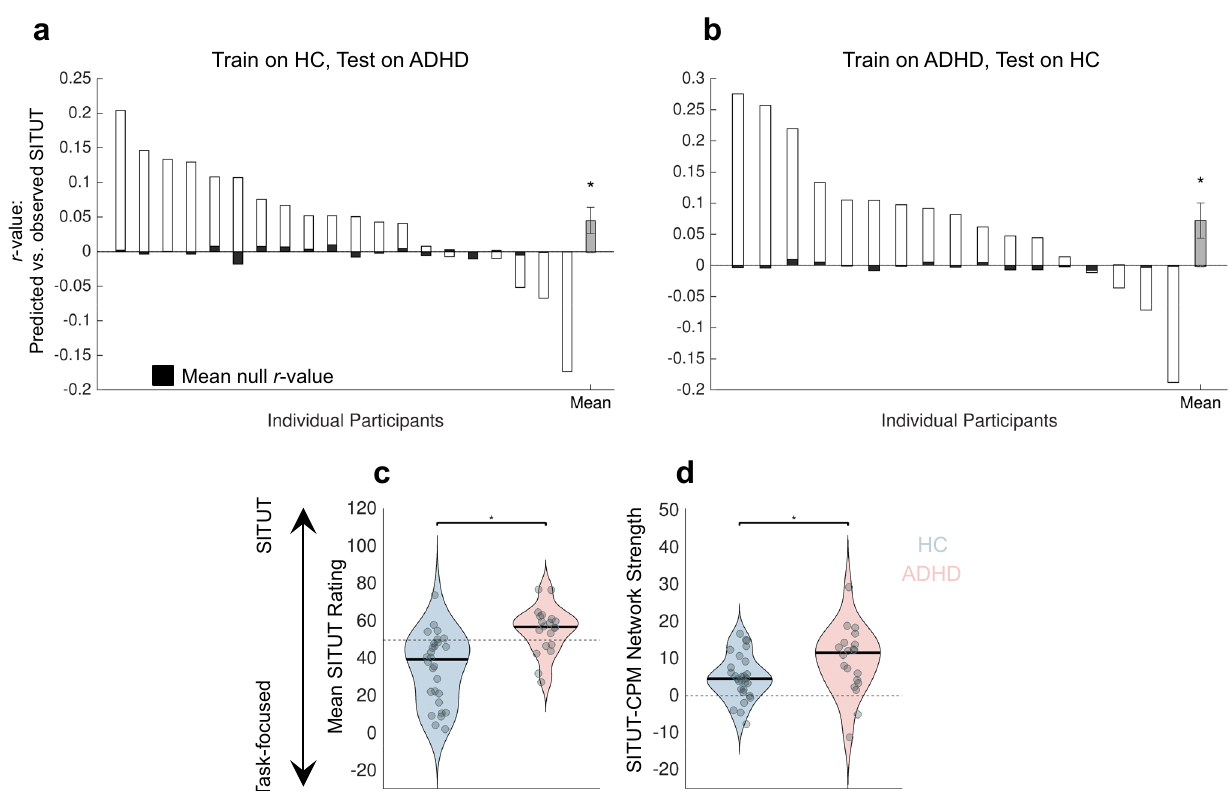
Fig. 3 The SITUT-CPM is sensitive to intra-individual mind wandering in adults with ADHD. a Predicted versus observed SITUT correlations, and mean null correlations, within each held-out participant with ADHD, based on the SITUT-CPM generated in healthy control (HC) participants. At the group level ( n = 20 individuals with ADHD), predicted versus observed correlations were signi fi cantly greater than mean null correlations (* P = 0.028, two-sided, Wilcoxon signed-rank test). The gray bar indicates the mean across individuals (i.e., mean across white bars). b Same as a but for held-out HC participants ( n = 17) based on a CPM generated to predict SITUT within ADHD participants (* P = 0.015, two-sided, Wilcoxon signed-rank test). c Mean SITUT ratings were signi fi cantly greater in the ADHD compared to HC group (* P = 9.6 × 10 − 5 , two-sided, Wilcoxon rank-sum test). d SITUT-CPM network strength, averaged across gradCPT runs within each participant, was signi fi cantly greater in the ADHD compared to HC group (* P = 0.039, two-sided, Wilcoxon rank-sum test). Error bars indicate standard error of the mean. Solid black lines in c and d indicate median. SITUT stimulus-independent, task-unrelated thought, CPM connectome-based predictive model. * P < 0.05. Source data are provided as a Source data fi le. Table 1 Participant characteristics for three rs-fMRI datasets included in analyses of trait SITUT.